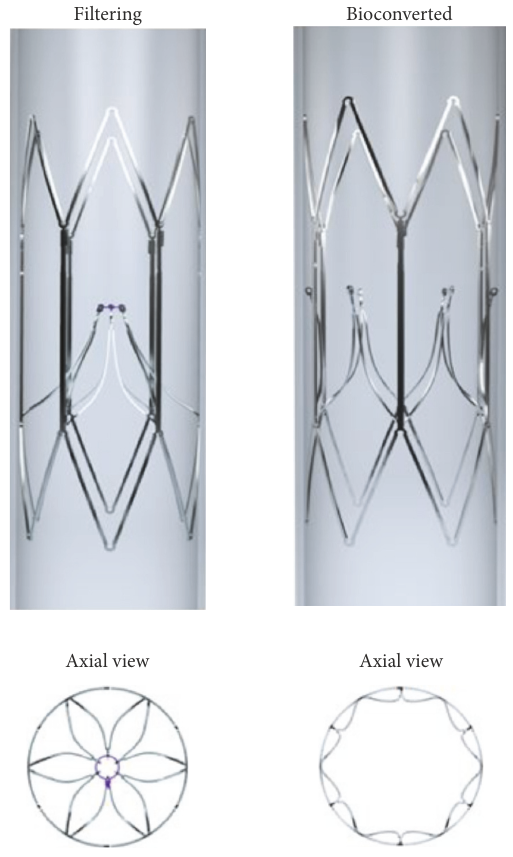
Figure 1: Sentry IVC filter in filtering (left) and bioconverted (right)